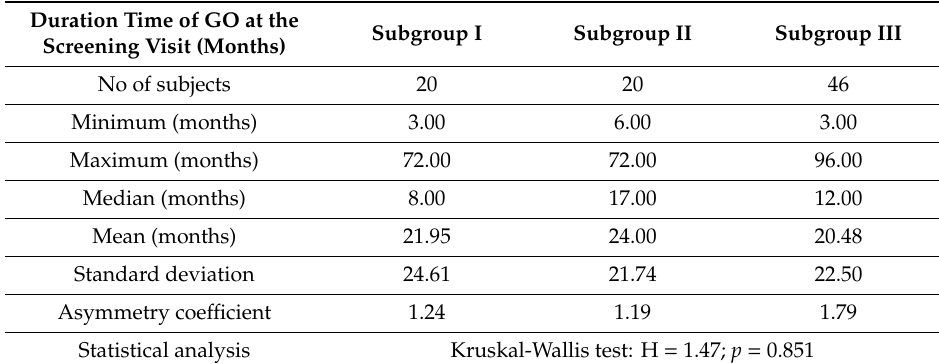
Table 4. Analysis of Graves’ orbitopathy (GO) duration time in the study population at the screening